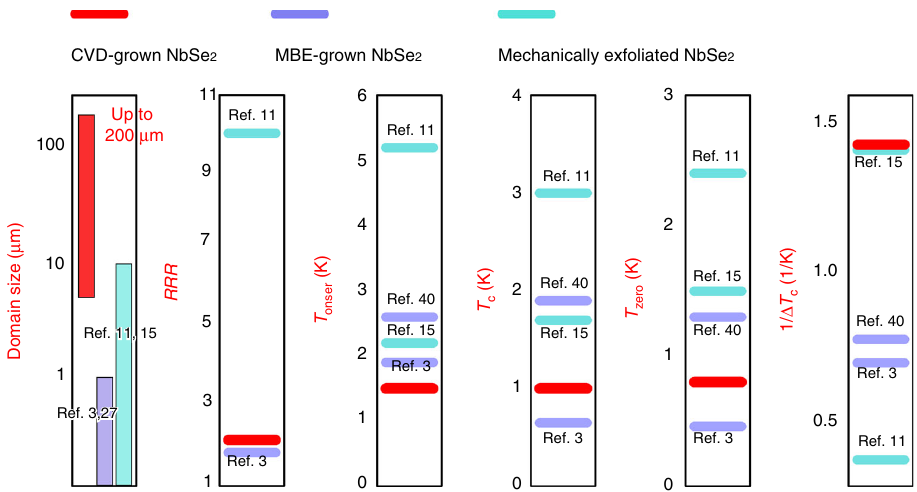
Fig. 5 Comparison of the superconducting performance of monolayer NbSe 2 prepared by CVD and other methods. From left to right : domain size,